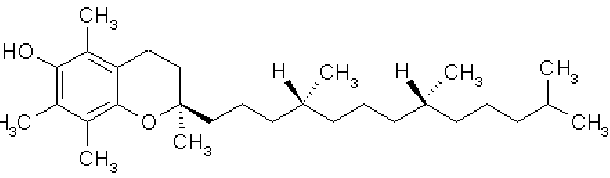
Figure 9. Chemical structure of vitamin E, (2 ′ R, 4 ′ R, 8 ′ R)-tocopherol.